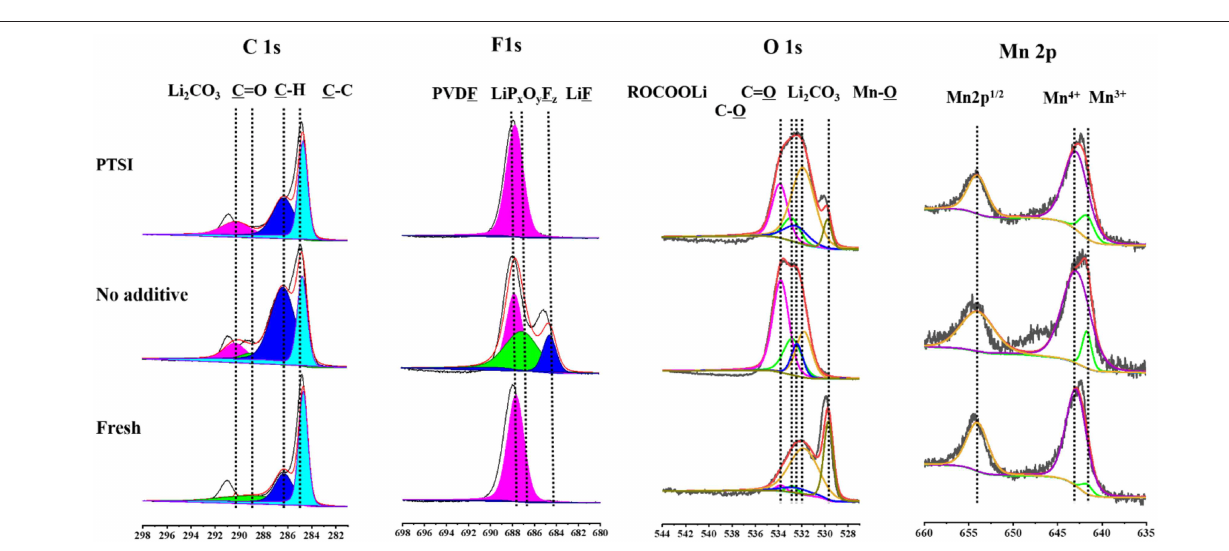
erosion to the electrode and inhibit the transport of Li ions. Hence, the impedance of LNMO electrode surface will increase accordingly. So, the SEI film generated by PTSI enhances the electrical charge transfer channel between LNMO electrode and